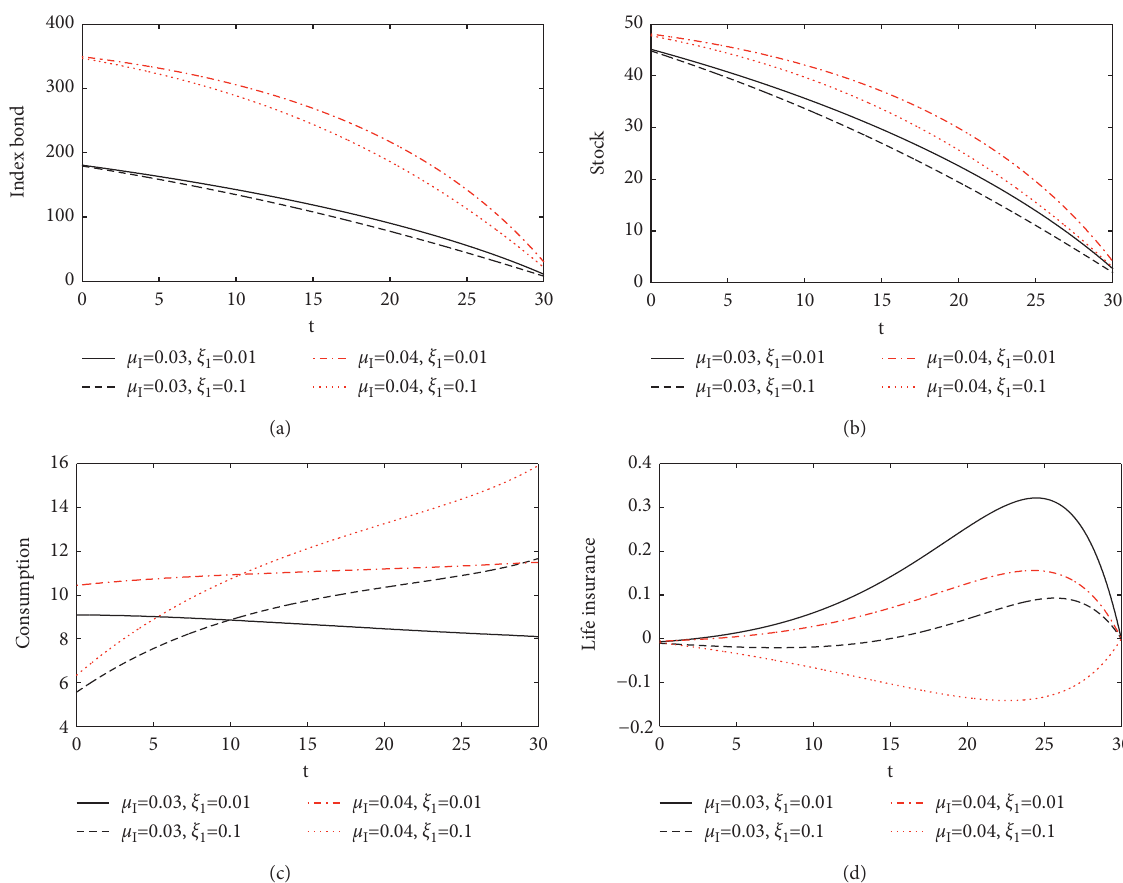
Figure 1: The effects of the expected inflation rate and consumption habit on the optimal